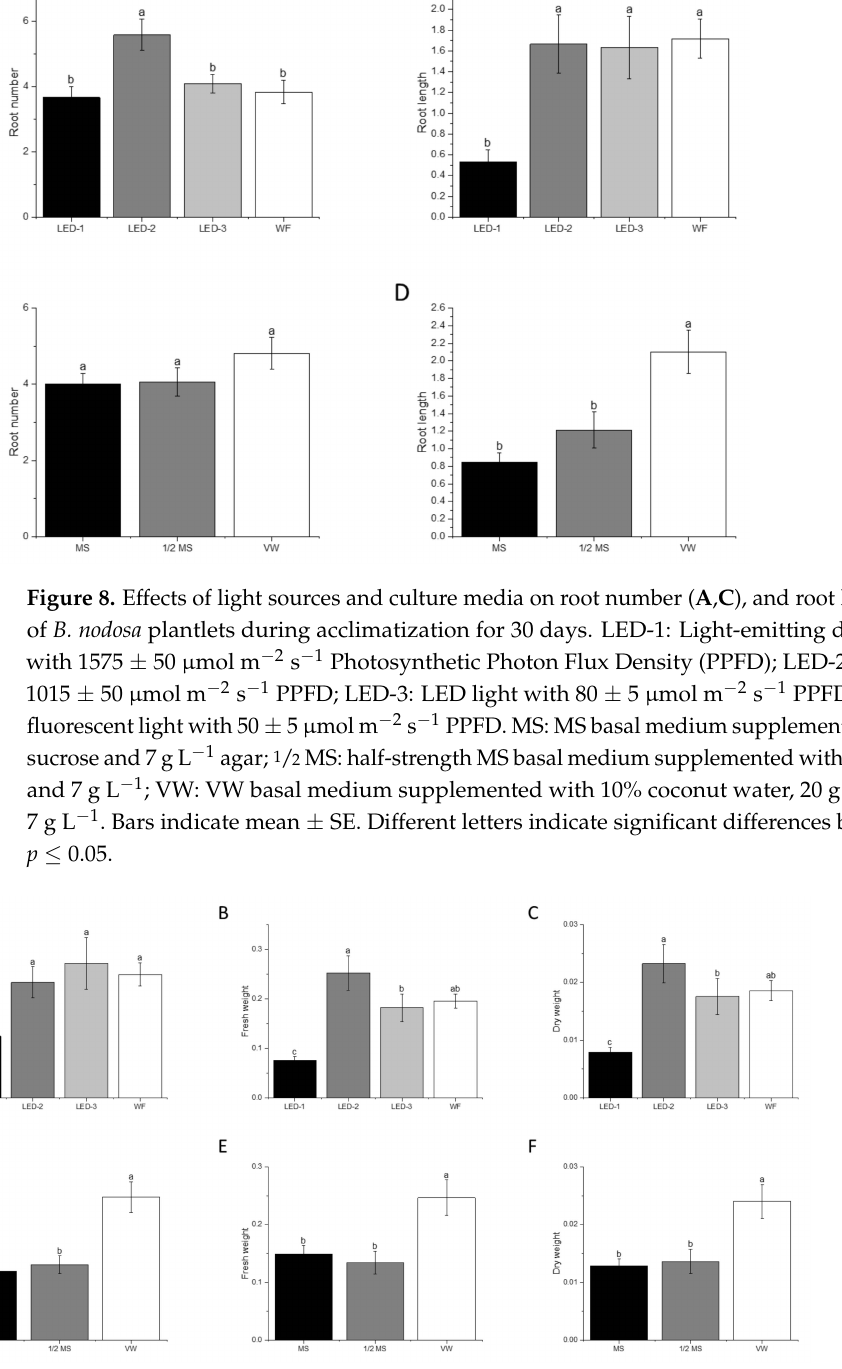
Figure 9. Effects of light sources and culture media on shoot length (g) ( A , D ), fresh weight (g) ( B , E ), and dry weight (g) ( C , F ) of B. nodosa during acclimatization for 30 days. LED-1: Light-emitting diode (LED) light with 1575 ± 50 µ mol m − 2 s − 1 Photosynthetic Photon Flux Density (PPFD); LED-2: LED light with 1015 ± 50 µ mol m − 2 s − 1 PPFD; LED-3: LED light with 80 ± 5 µ mol m − 2 s − 1 PPFD; and WF: white fluorescent light with 50 ± 5 µ mol m − 2 s − 1 PPFD. MS: MS basal medium supplemented with 30 g L − 1 sucrose and 7 g L − 1 agar; 1 / 2 MS: half-strength MS basal medium supplemented with 15 g L − 1 sucrose and 7 g L − 1 ; VW: VW basal medium supplemented with 10% coconut water, 20 g L − 1 sucrose and 7 g L − 1 . Bars indicate mean ± SE. Different letters indicate significant differences by Tukey’s test at p ≤